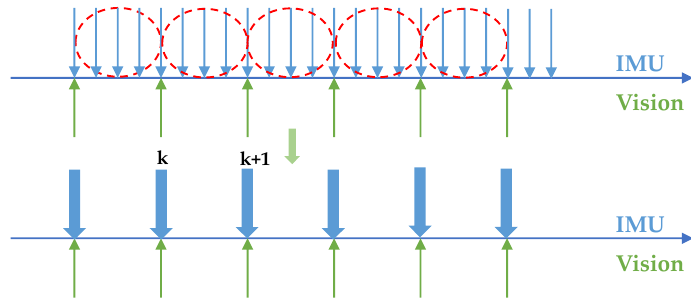
Figure 3. Diagram of IMU model.